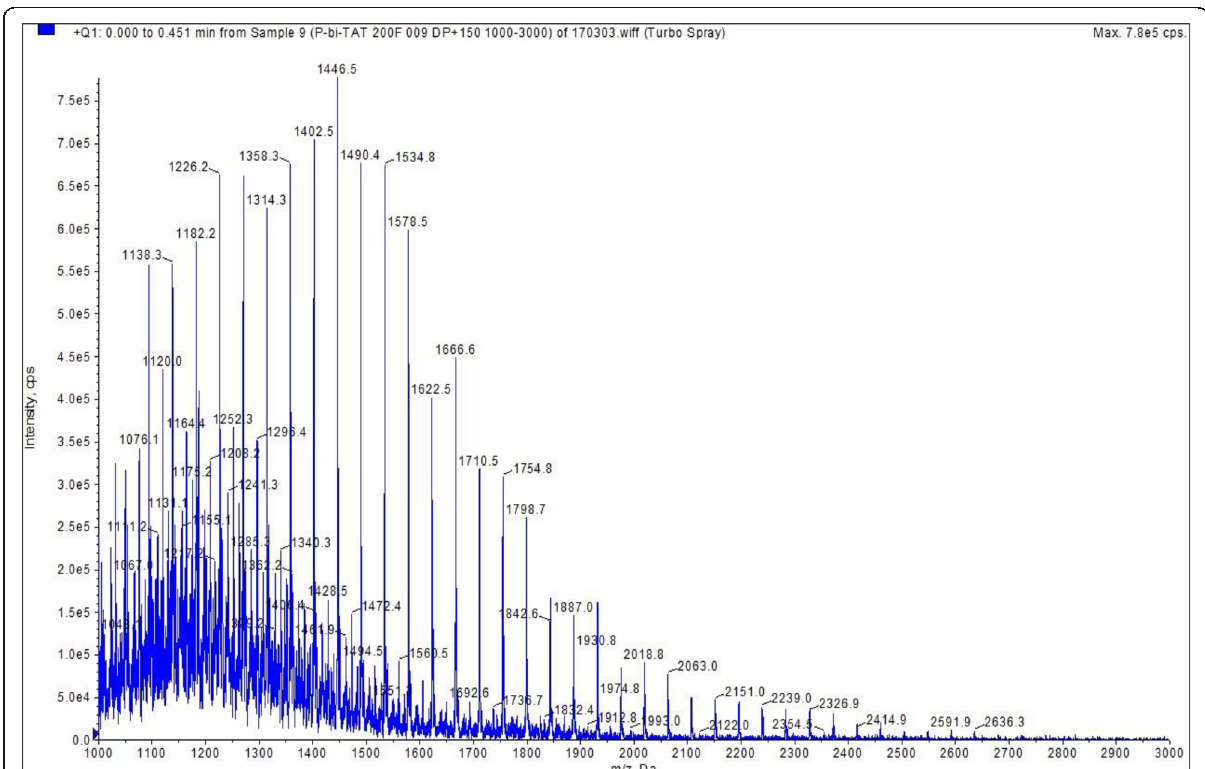
Fig. 4 Full scan mass spectrum (Q1MS) of P-bi-TAT by in-source CID in positive